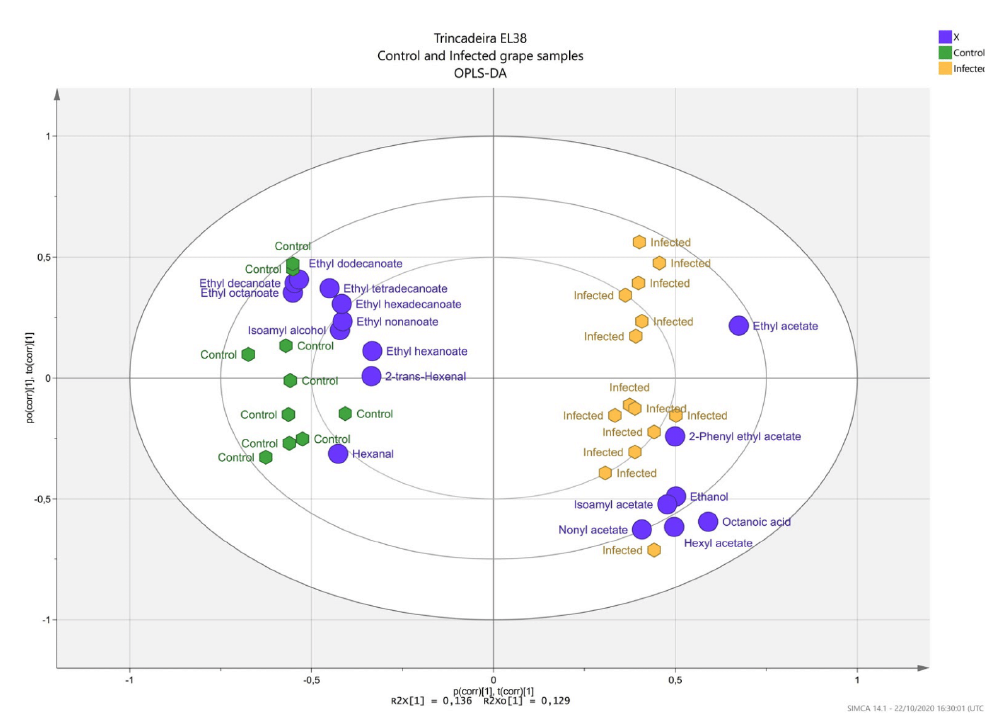
Figure 3. Biplot Orthogonal Projections to Latent Structures—Discriminant Analysis (OPLS–DA) of V. vinifera cv. Trincadeira samples upon infection by B. cinerea ; infection status was selected as the Y-variable. The samples show a separation according to volatile organic compounds. Samples are coloured according to the following condition: green hexagons represent control samples (four biological and two–three technical replicates); yellow hexagons represent infected samples (seven biological and two technical replicates); purple circles represent the volatile